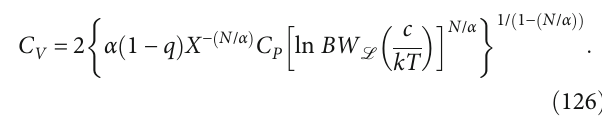
Figure 5: (a) Graph of C when q ′ , r vary and q = 0 : 4 , T = 2 , P = 3 , D = 1 , and k = A = 1 . (b) Graph of C P ∗ P = 4 , D = 1 , and k = A = 1